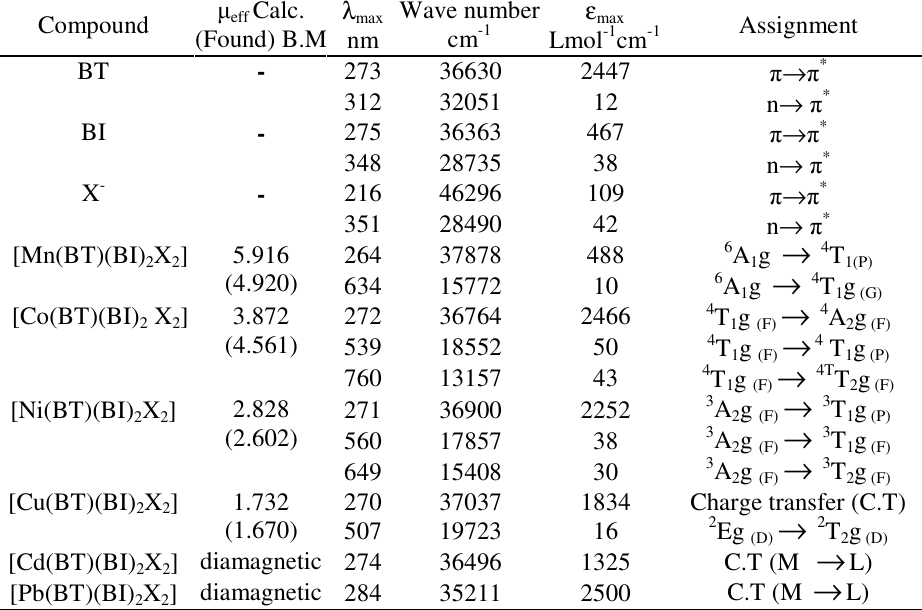
Table 2. Magnetic susceptibility and electronic spectra of the ligands and its complexes µ eff Compound